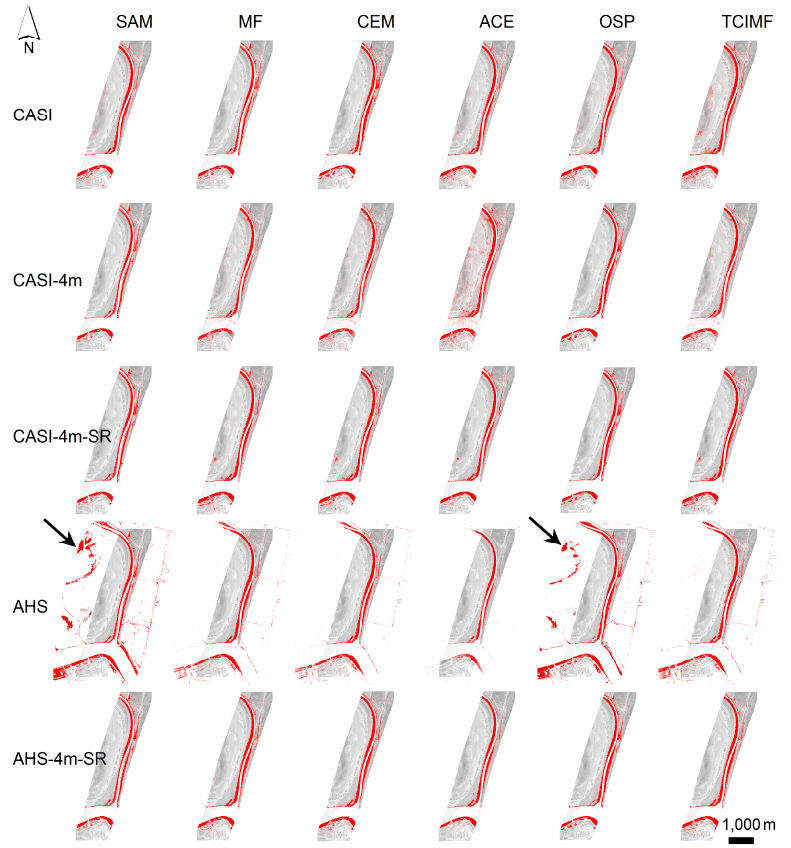
Figure 5. Predicted distribution of Spartina densiflora according to each model. S. densiflora prediction in red. Detection algorithms (in columns): Spectral Angle Mapper (SAM), Matched Filter (MF), Constrained Energy Minimization (CEM), Adaptive Coherence Estimator (ACE), Orthogonal Subspace Projection (OSP) and Target-Constrained Interference-Minimized Filter (TCIMF), and hyperspectral image (in rows) CASI, CASI-4m, CASI-4m-SR, AHS, and AHS-4m-SR. The gray background represents the study area defined by the overlap of the footprints of the CASI and AHS sensors. Black arrows represent known prediction errors by SAM and OSP at “Lucio de los Ansares” shores where we know S. densiflora is not present.